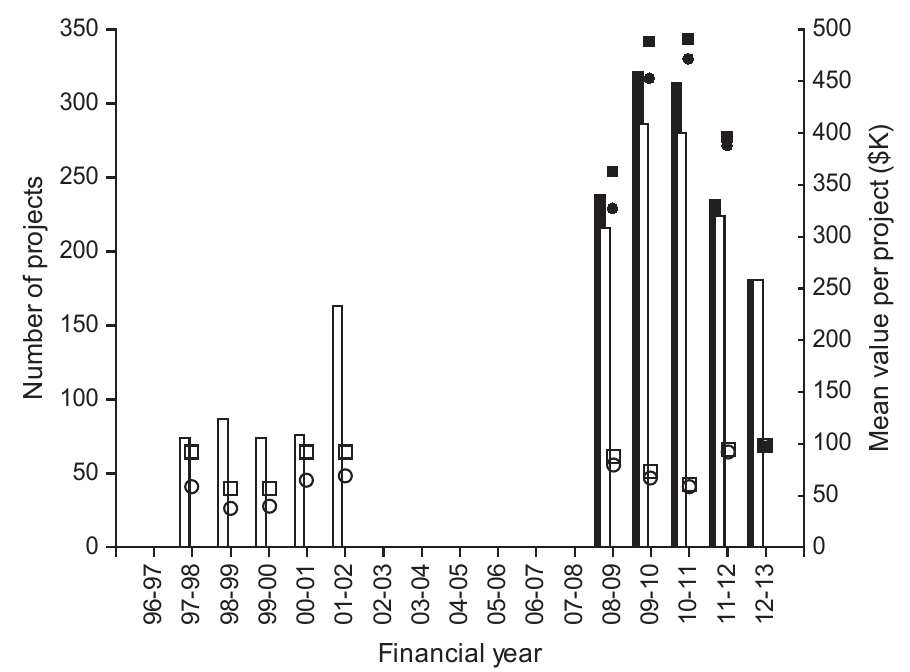
Figure 2. Number (columns) and mean value (points) of projects funded per financial year including (black) and excluding (white) base-level allocations of funding using actual data (circles), and data ad- justed for inflation to 2013 values (squares). Missing data could not be